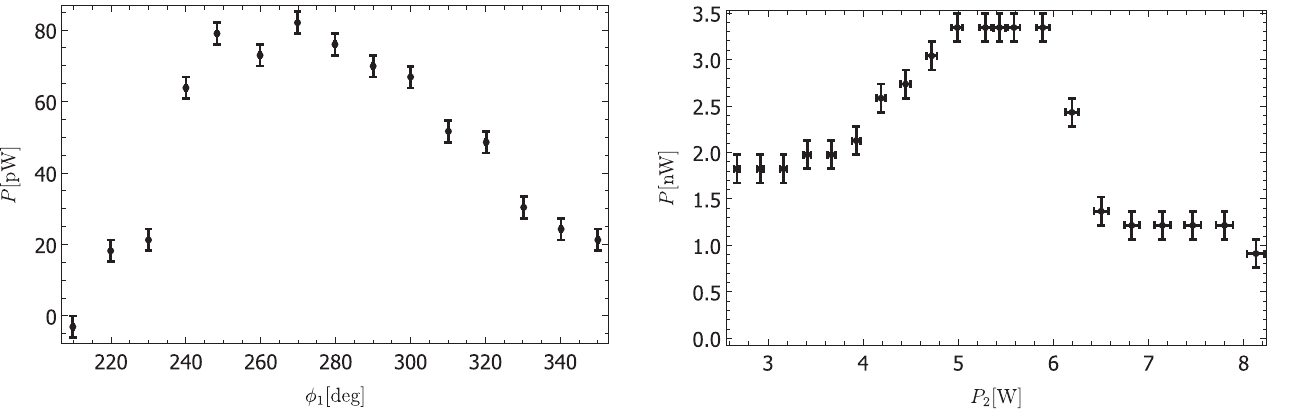
FIG. 8. SPR power P to the phase of the first-harmonic buncher cavity ϕ 1 at a fixed value of P 1 ¼ 15 W. The second buncher cavity is turned off.